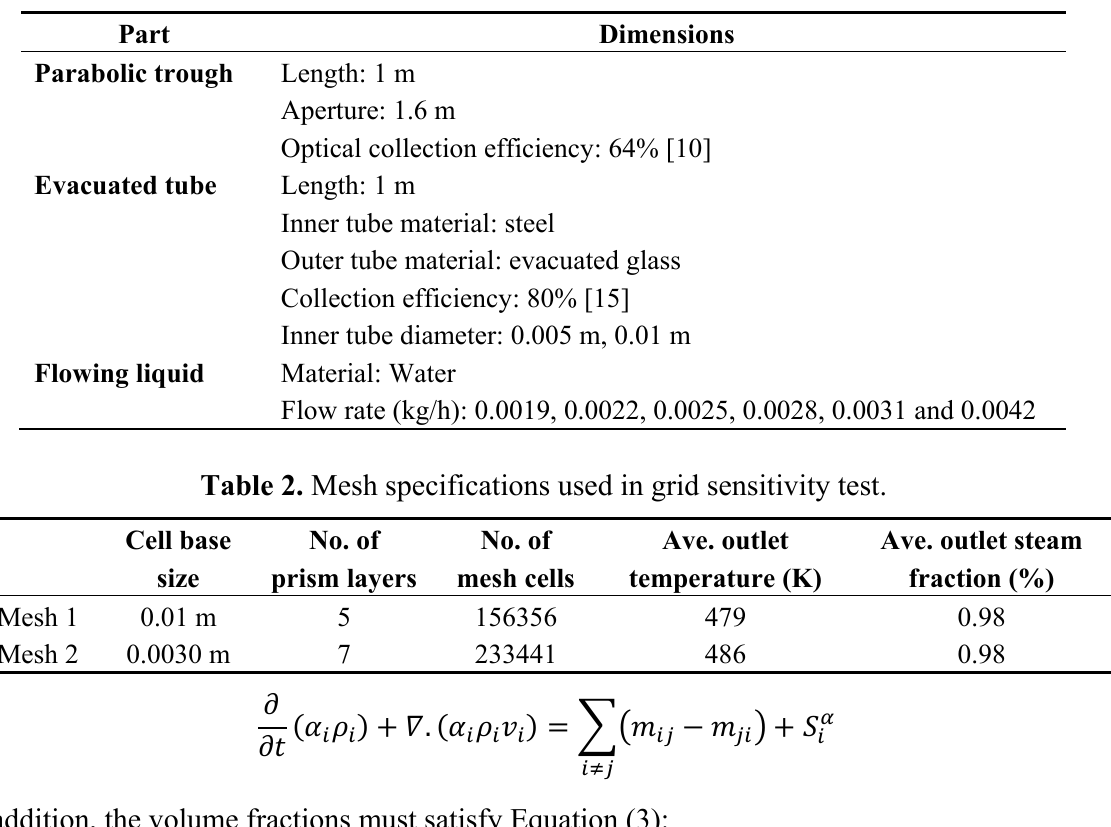
Table 1. Dimensions and material of the proposed system.